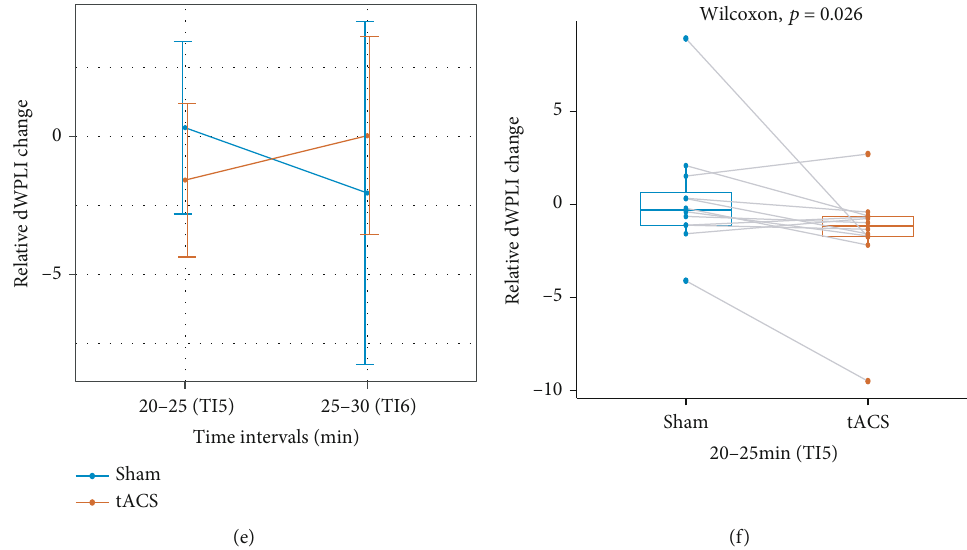
Figure 6: (a) Sustained attention in the two stimulation groups (sham/tACS) both declined with experimental time going on. There were no signi fi cant interaction or stimulation e ff ects, but there was a signi fi cant main e ff ect of time intervals, and the post hoc comparisons can be found in Table 1. (b) Sustained attention in the tACS group had a declining trend compared to the sham group in the fi fth time interval (20-25min) when the tACS was just terminated, p = 0 : 068 . (c) There were no main e ff ects or interactions between stimulation and time intervals in power in 20-25min (TI5) and 25-30 min (TI6) after stimulation. (d) There were no signi fi cant di ff erences in power between sham and true tACS groups in the fi fth time interval (20-25 min) when the tACS was just terminated, p = 1 . (e) There were no main e ff ects or interactions between stimulation and time intervals in phase-based connectivity (indexed by dWPLI) in 20-25 min (TI5) and 25- 30min (TI6) after stimulation. (f) Phase-based connectivity in the tACS group signi fi cantly decreased compared with the sham group in the fi fth time interval (20-25min) when the tACS was just terminated, p = 0 : 026 . Table 1: Multiple comparisons of time intervals in behavioral results.